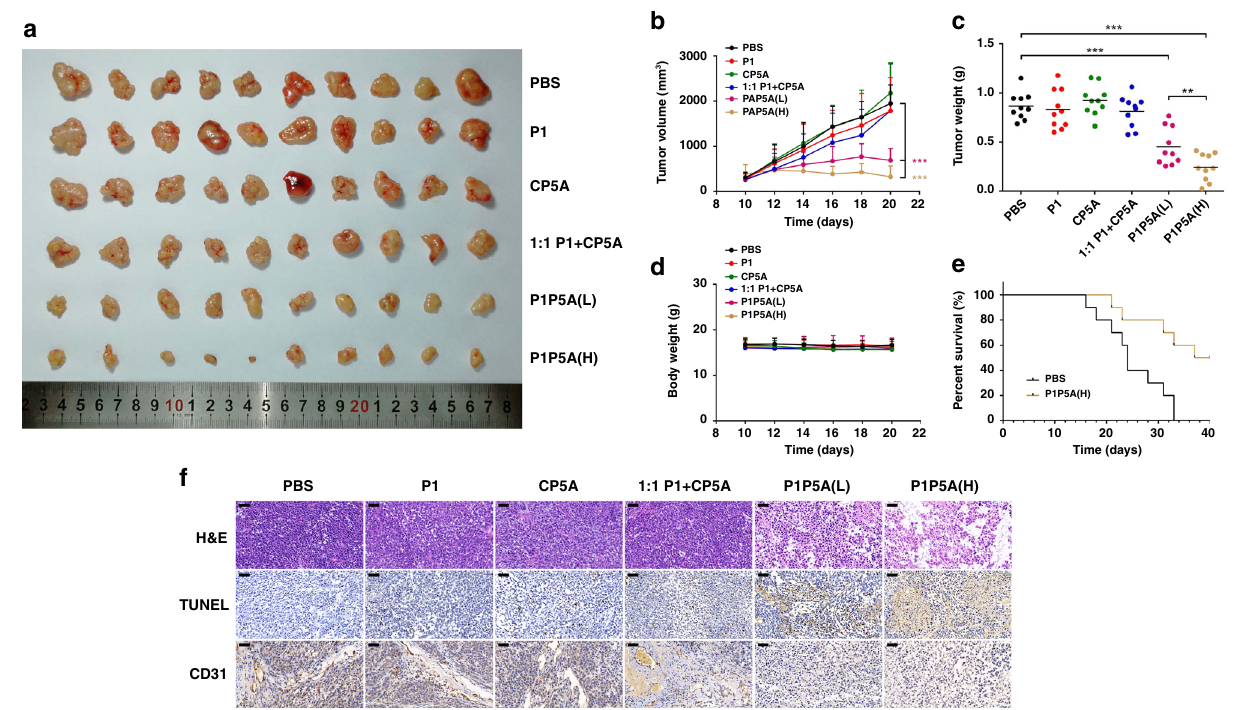
Fig. 5 In vivo antitumor experiments. a Images of tumors excised from MCF-7 xenograft nude mice treated with PBS (control), free P1, free CP5A, a 1:1 mixture of P1 and CP5A, low-dose P1P5A (L), and high-dose P1P5A (H); b Tumor growth curves of the MCF-7 tumor model in the groups treated with PBS, P1, CP5A, 1:1 P1 + CP5A, P1P5A (L), and P1P5A (H), mean ± SD ( n = 10 mice per groups); c normalized tumor weights at 10 days after treatment with PBS, P1, CP5A, 1:1 P1 + CP5A, P1P5A (L), and P1P5A (H), mean ± SD ( n = 10 mice per group); d changes in body weight observed for MCF-7 xenograft nude mice after treatment with PBS, P1, CP5A, 1:1 P1 + CP5A, P1P5A (L), and P1P5A (H), mean ± SD ( n = 10 mice per group); e survival rates of nude mice bearing MCF-7 tumors treated with PBS and P1P5A (H) ( n = 10 mice per group); f H&E, TUNEL, and CD31 analyses of tumor tissue at 10 days after treatment with PBS, P1, CP5A, 1:1 P1 + CP5A, P1P5A (L), and P1P5A (H) (scale bar: 50 μ m). Signi fi cant differences were assessed in ( b ) and ( c ) using the t test. ** p < 0.01, *** p <